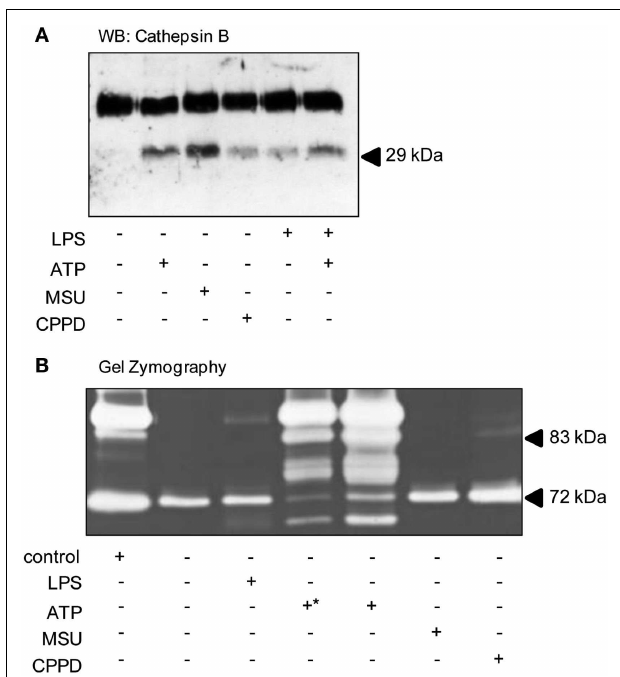
FIGURE 5 | DAMPs induce the release of proteases from cultured mixed glia. Cultured mixed glia were treated with the NLRP3-activating DAMPs ATP (5mM), MSU, and CPPD (both 250 µ g/ml) or the PAMP LPS (1 µ g/ml) for 24h. Supernatants were analyzed for the release of mature Cathepsin B (28–30kDa) byWestern blot (A) .To measure the release of martix metalloproteases by zymography all samples were loaded neat onto gels except for one of the ATP-treated supernatants ( + *) which was diluted 1:3 (B) . Blots and gels shown are representative of at least five separate